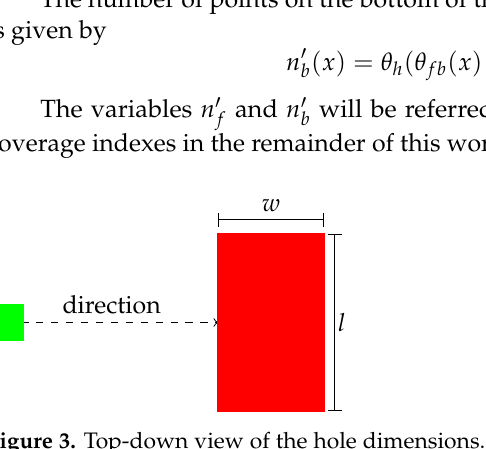
Figure 3. Top-down view of the hole dimensions. The green square represents the sensor, the red square represents the